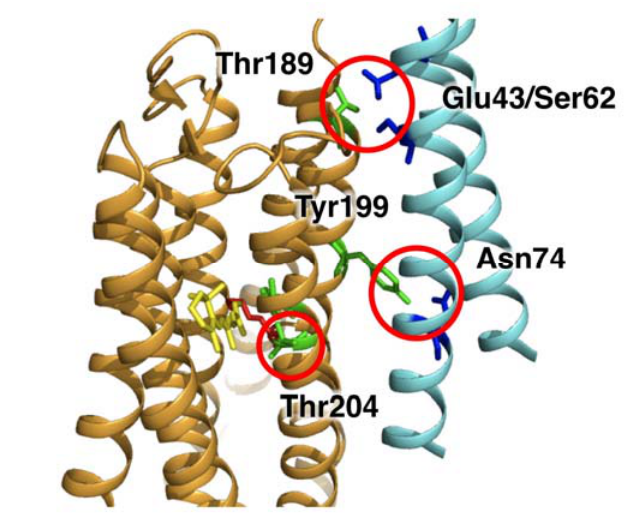
bonds between Tyr199 SRII and Asn74 HtrII and between Thr189 SRII and Glu43 HtrII /Ser62 HtrII . The membrane normally is roughly in the vertical plane of this image, and the top and bottom regions correspond to the extracellular and cytoplasmic sides,